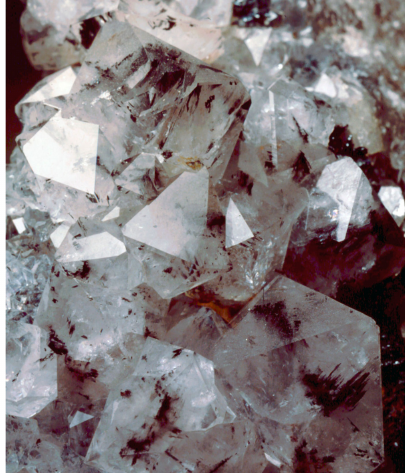
Figure 17. Quartz with hematite inclusions, Chub Lake prospect. Field of view, 10 cm. Chamberlain Collection, NYSM 12191. SC.